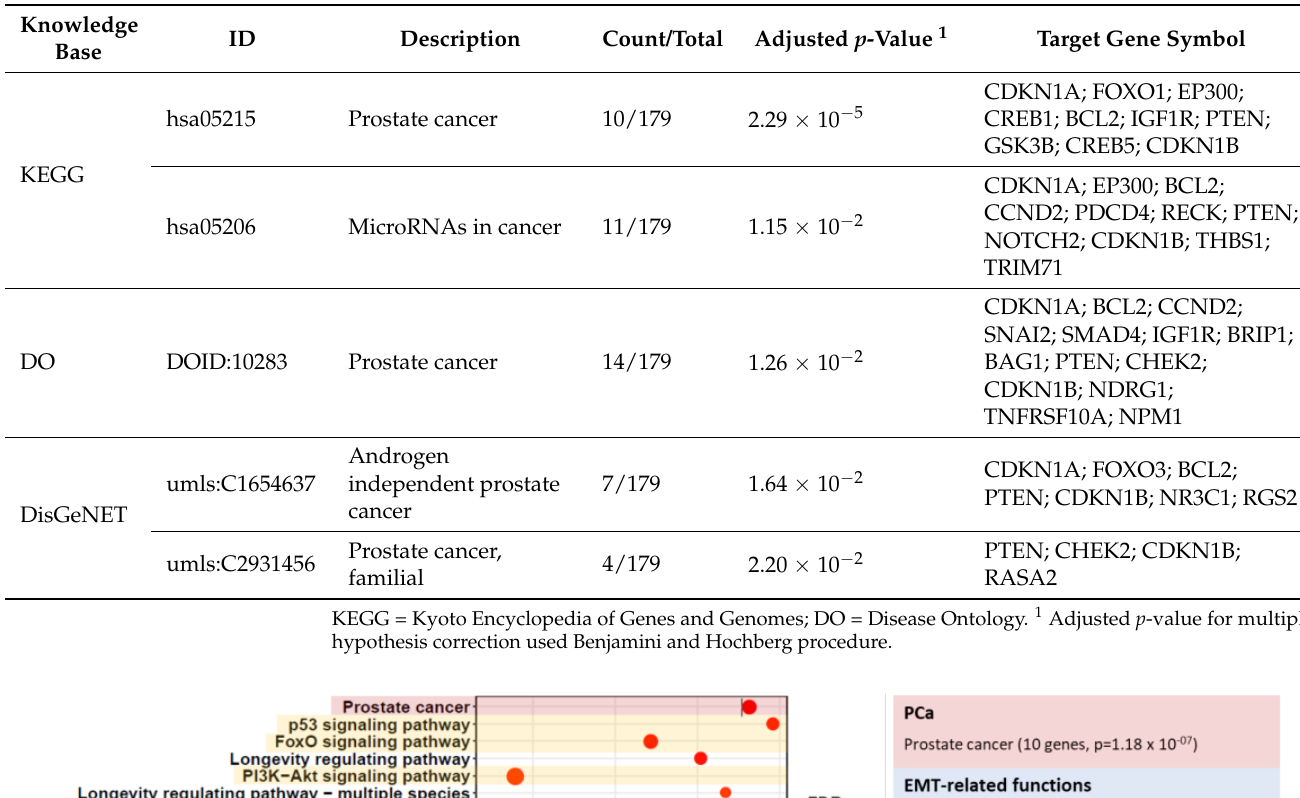
Table 1. Functional enrichment analysis of miR-182 in prostate cancer. Table shows the significant association of miR-182 target genes with Gene Set descriptions related to prostate cancer. Analysis performed using clusterProfiler in CancerMIRNome.